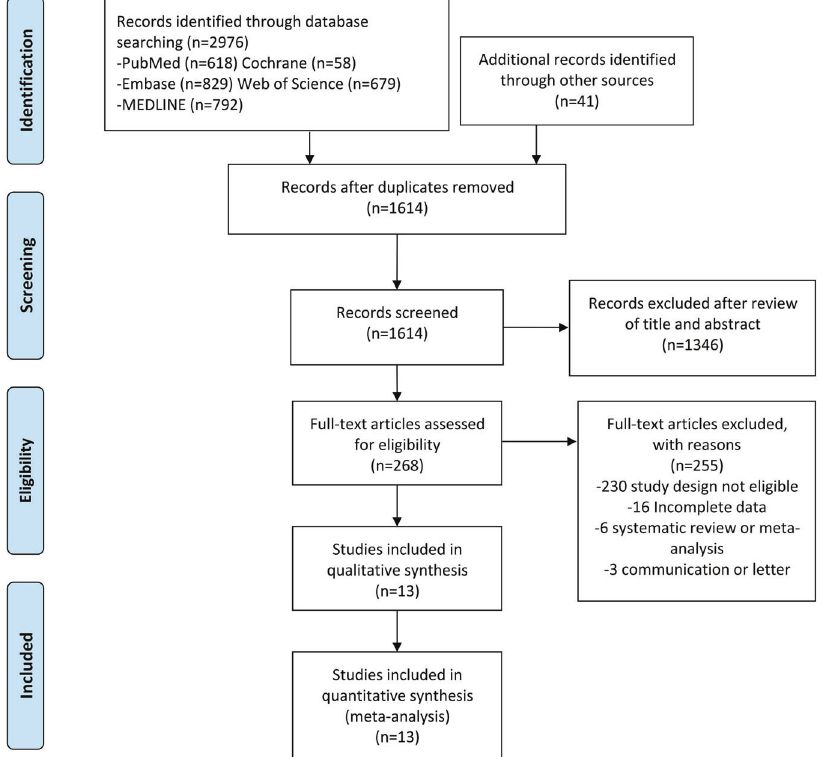
Fig. 1 PRISMA fl ow diagram. Preferred Reporting Items for Systematic Reviews and Meta-Analyses (PRISMA) study selection fl ow